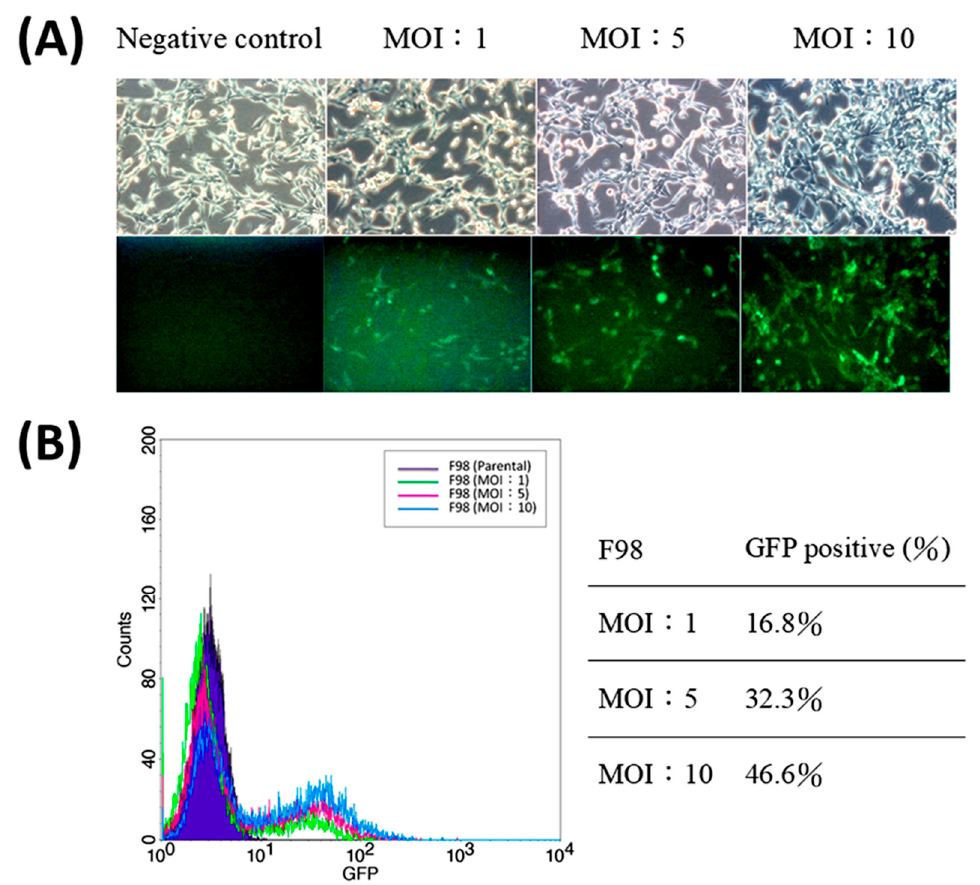
Figure 3. Characteristics of F98 cells transfected with FGT triple reporter genes. ( A ) F98 / FGT cells were observed using a fluorescent microscope (Leica DM6000B, Wetzlar, Germany) with 100 × magnification under multiplicity of infection (MOIs) of 1, 5, and 10 ( FGT : F, firefly luciferase; G, enhanced green fluorescent protein; and T, thymidine kinase). ( B ) The intensities of green fluorescence were analyzed with a FACScan flow cytometer (Beckman Coulter CytoFLEX, Brea, CA, USA). The percentages of GFP-positive F98 / FGT cells were 16.8%, 32.3%, and 46.6% for MOI-1, -5, and -10, respectively.